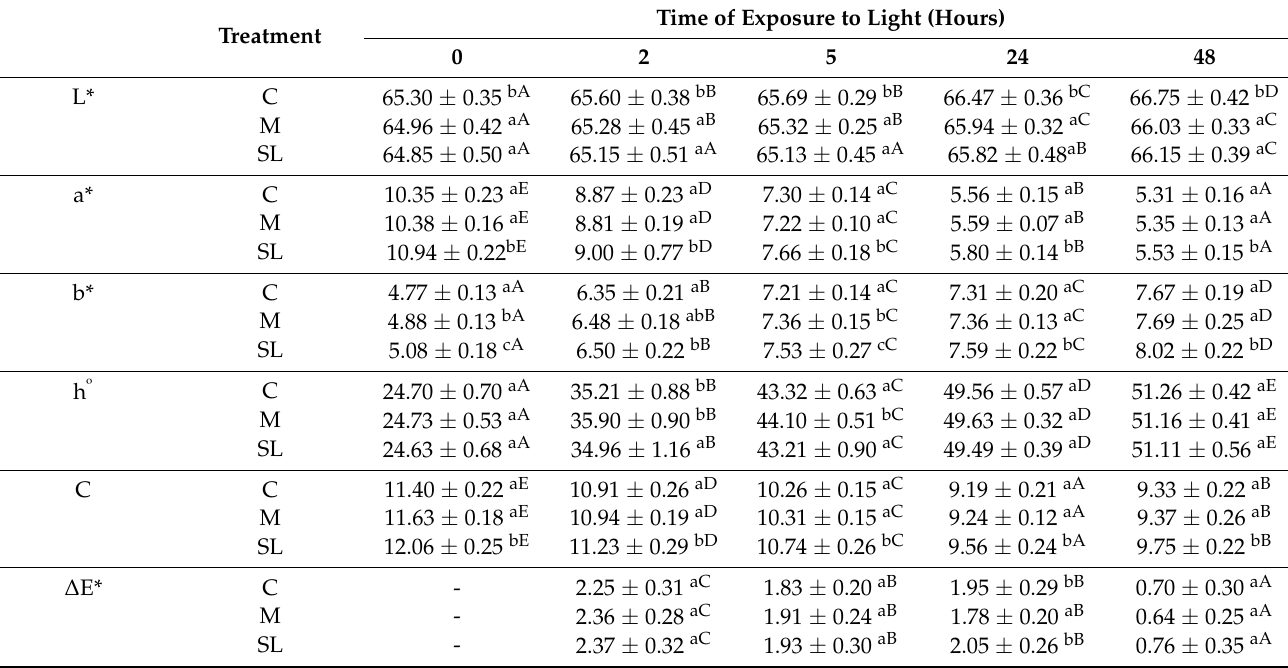
Table 3. The colour parameters (L*, a*, b*, hº, C*, ∆ E*) of the model meat products tested after exposure to light after eight weeks of refrigerated storage (means ± standard deviation). Time of Exposure to Light Treatment